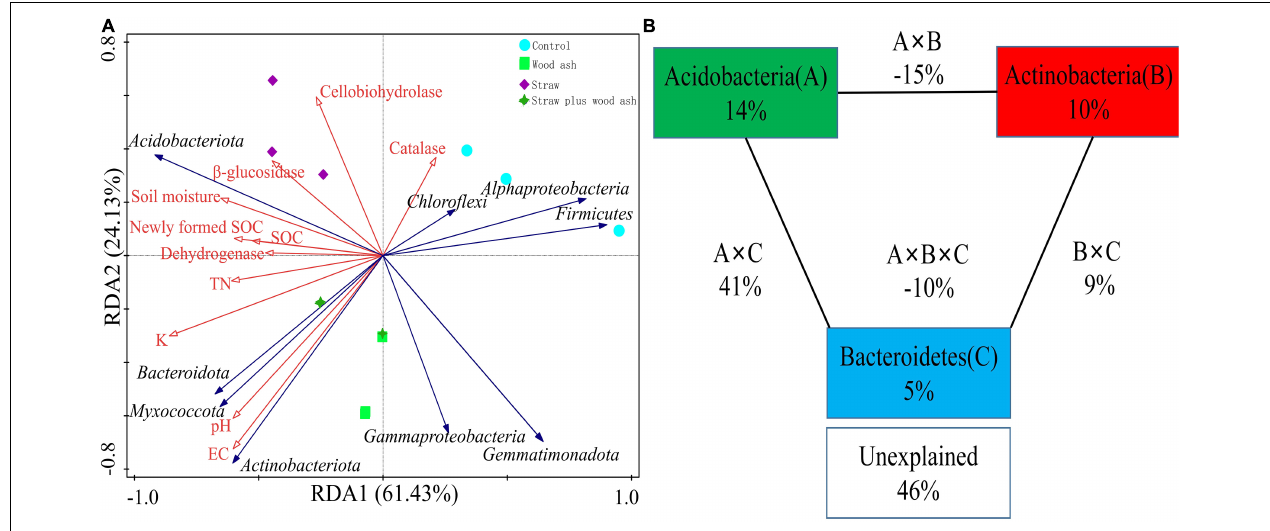
FIGURE 4 | Distance-based redundancy analysis to show the correlations between the bacterial phyla and chemical characteristics (A) and variance partition analysis (B) between the sequestered SOC of bacterial phyla from different